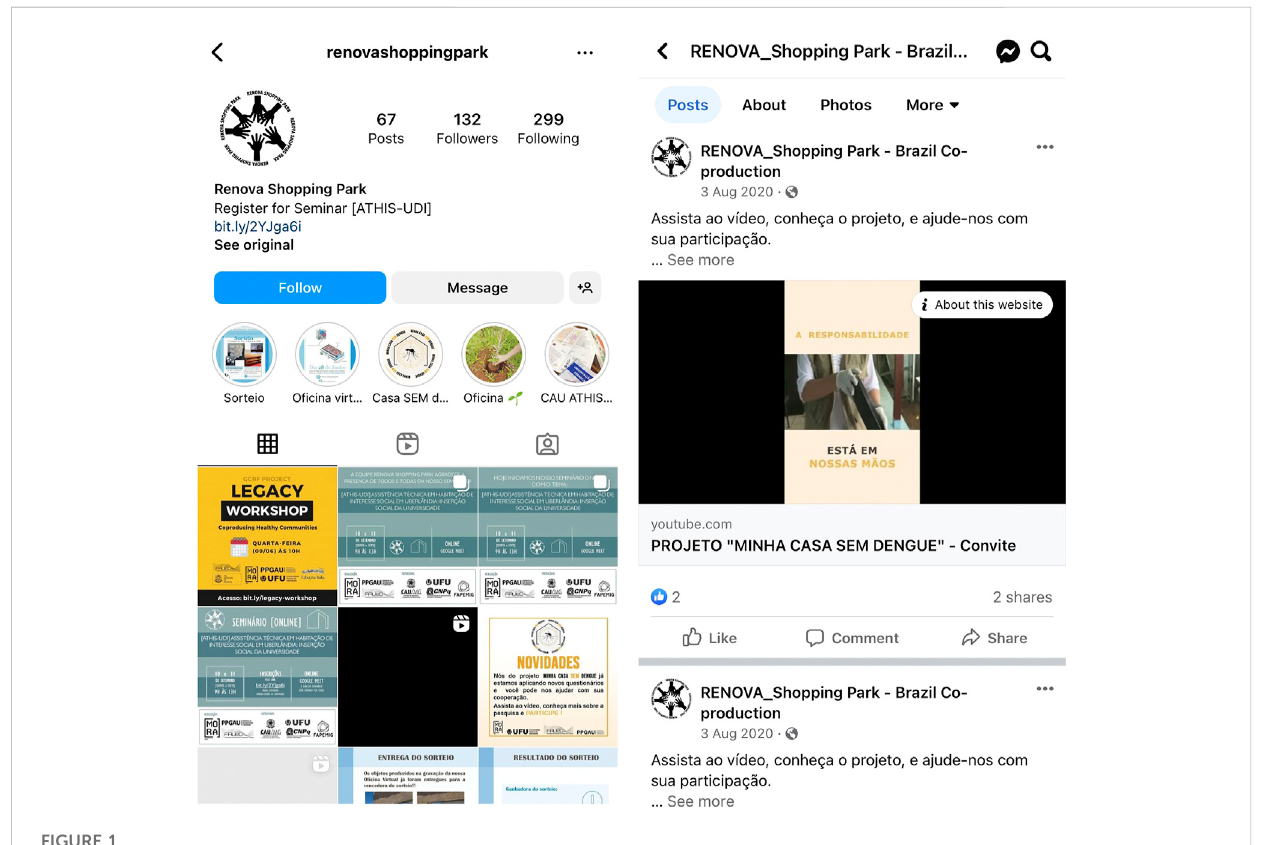
FIGURE 1 Social media pro fi le pages of the project ’ s Instagram and Facebook